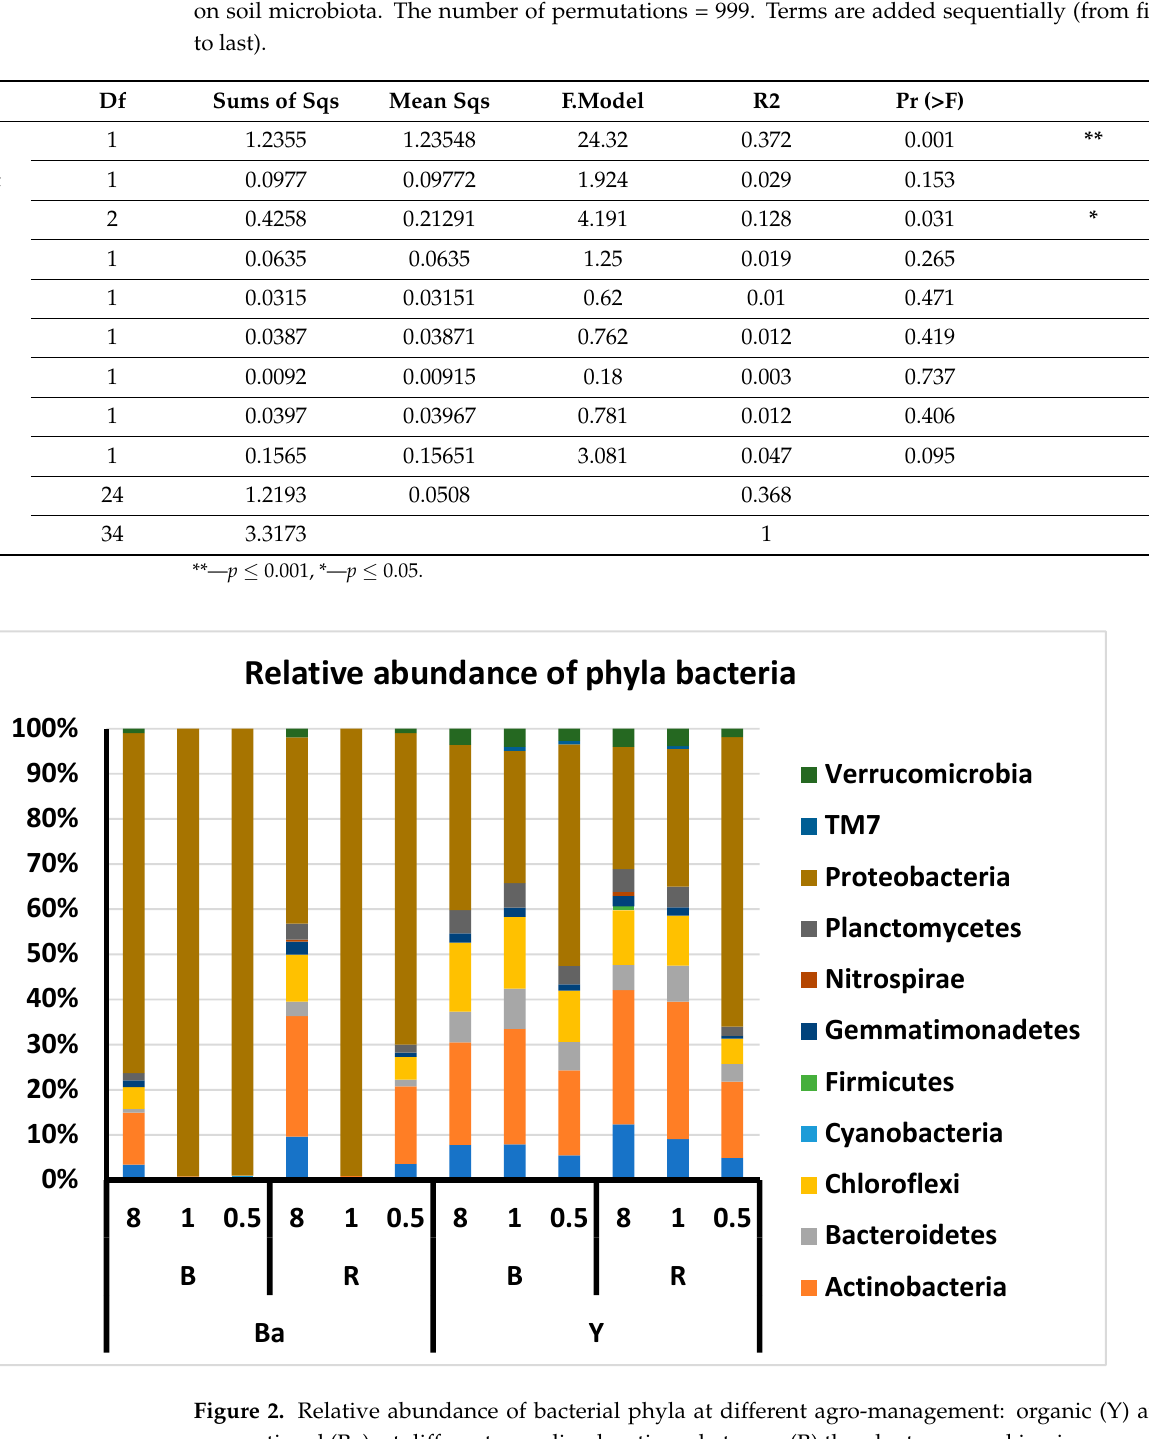
cant effect of vineyard agro-management and aggregate size in comparison with other abiotic factors